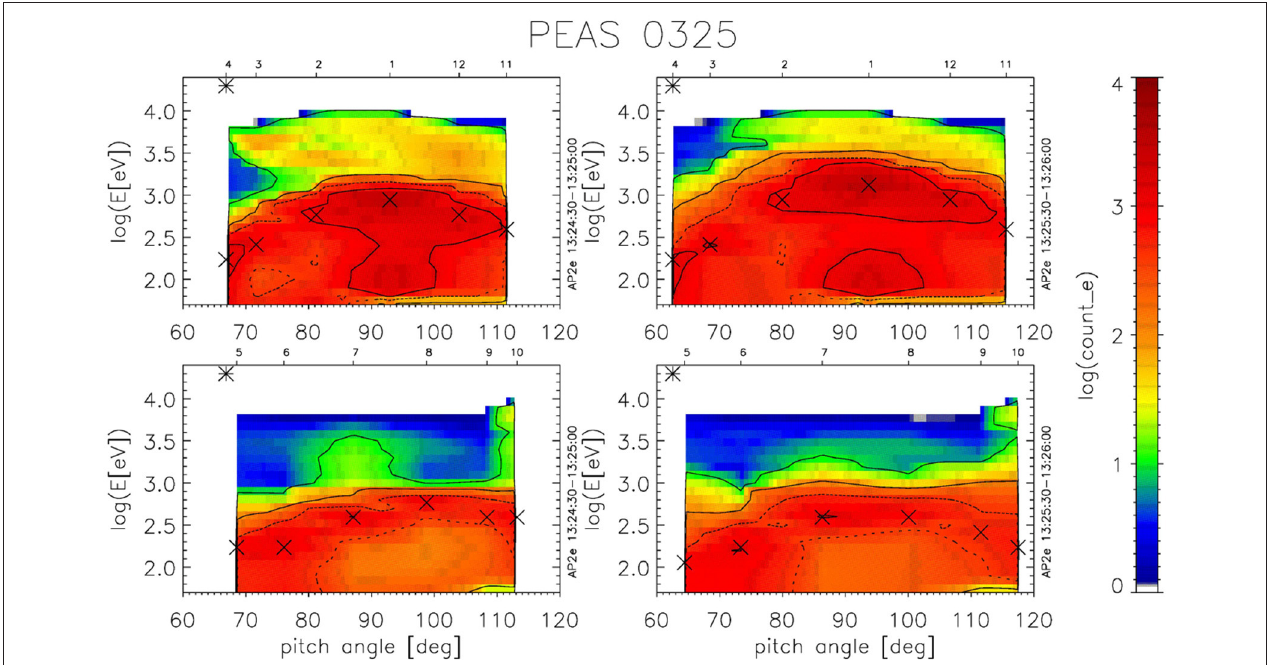
FIGURE 8 | The electron energy and pitch angle distribution obtained with the PEAS AP–2 sensor during electron beam emission (orbit 325, G2 injector with magnetic deflection, F40K mode) accompanied by xenon plasma injection (F0 mode) on the left and neutral xenon (Xe-B) on the right. (Top) AP–2 sectors seeing the electrons from inside the beam flux tube (group 1), (Bottom) Sectors seeing the electrons from outside (group 2). The UEM injection pitch angle denoted by ×+ . (Reprinted from Nemecek et al., 1997, copyright 1997 by the American Geophysical